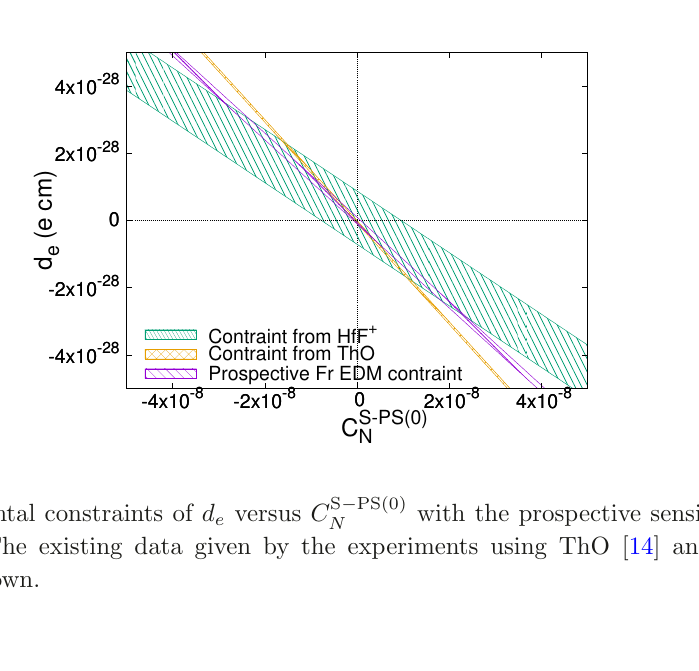
Figure 6 . Experimental constraints of d e versus C S EDM of Fr atom. The existing data given by the experiments using ThO [14] and HfF + [90] molecules are also